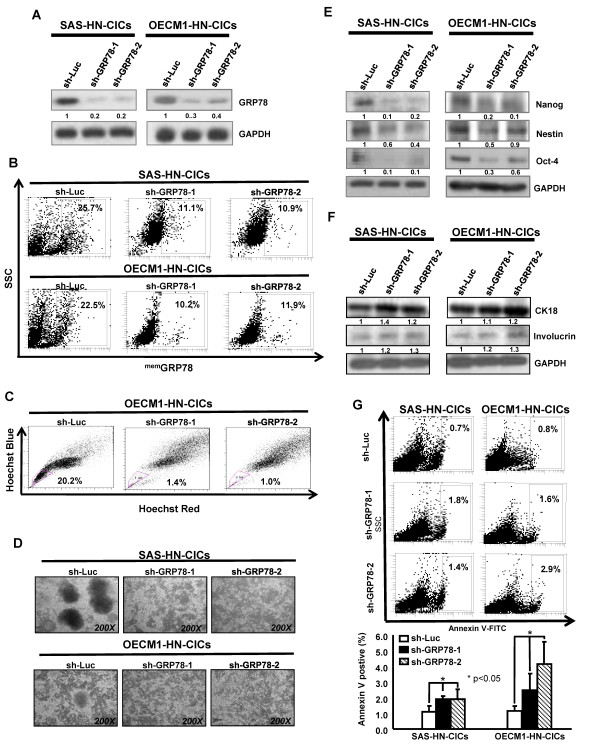
Suppression of GRP78/memGRP78 expression diminished spheres-forming capability, stemness genes expression, and side population cells of HN-CICs. (A) Down-regulation of GRP78 in HN-CICs (SAS (left panel) and OECM1 (right panel) mediated by shRNAi was validated by western blotting) (B) The percentages of memGRP78+ cells in sh-GRP78 knockdown and sh-Luc HN-CICs were compared by flow cytometry analysis, respectively. (C) Single cell suspensions of sh-GRP78 and sh-Luc-expressing HN-CICs incubated with Hoechst 33342 were examined for side population by flow cytometry. (D) HNSCCs-enriched sphere cells were first infected with Sh-GRP78-1, Sh-GRP78-2 or Sh-Luc lentivirus, and further cultivated under the serum-free defined selection medium. The tumor sphere formation capability and cellular morphology of enriched HN-CICs (Upper panel, SAS; Lower panel; OECM1) treated with either sh-Luc or GRP78-shRNA lentivirus were examined with microscope. (E) Total proteins from figure 3d were isolated and immublotted by using antibodies against, anti-Oct-4, anti-Nanog, anti-Nestin or anti-GAPDH antibodies as indicated. The amount of GAPDH protein of different crude cell extracts was referred as loading control. (F) Protein level of epithelial specific differentiation markers, CK18 and invoclurin in enriched HN-CICs cells infected with sh-Luc, or sh-GRP78 lentivirus was assessed by western blot. (G) Single cell suspension of spheres prepared from figure 3d transduced with sh-Luc or sh-GRP78 lentivirus were stained with Annexin V and examined by flow cytometry. The experiments were repeated three times and representative results were shown. Results are means ± SD (*, p < 0.05).